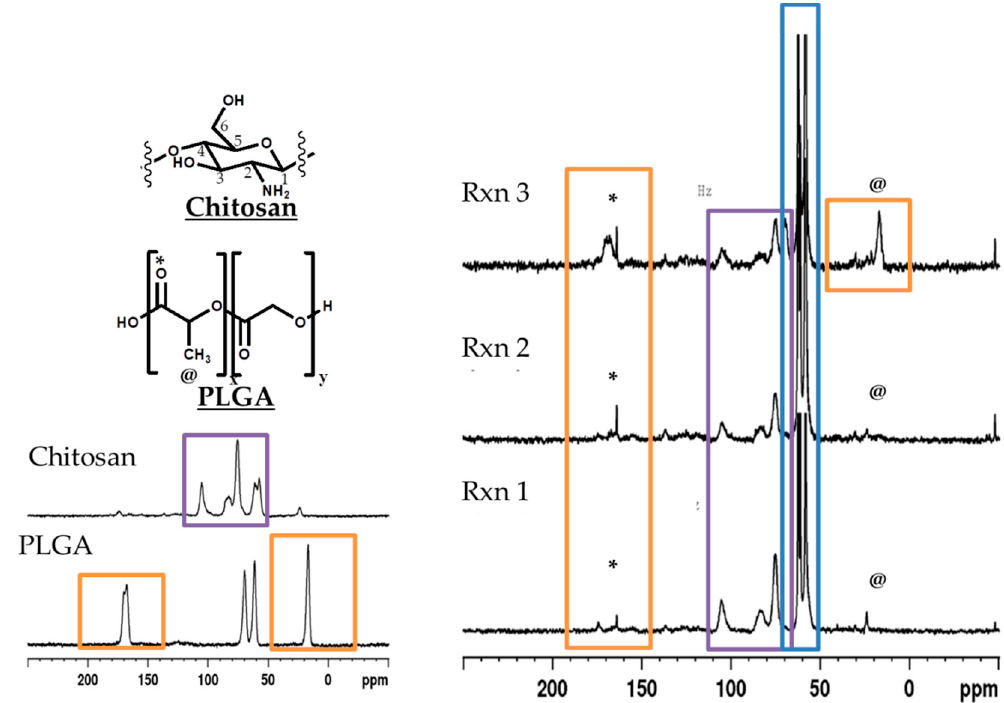
Figure 4. Solid state 13C NMR analysis with highlighted peaks of interest: chitosan ( purple ), PLGA ( orange ), TRIS salt ( blue ). Numbers indicate the Carbons (C1-6) of the chitosan ring structure or their respective hydrogens as depicted in the structure (Top left), * indicates the carbon of the PLGA carbonyl peak, and @ indicating the PLGA methyl group.